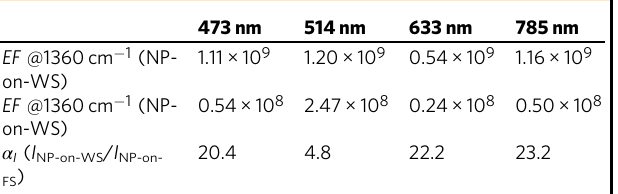
Table 1 A summary of EF at 1360 cm − 1 and α I for four different